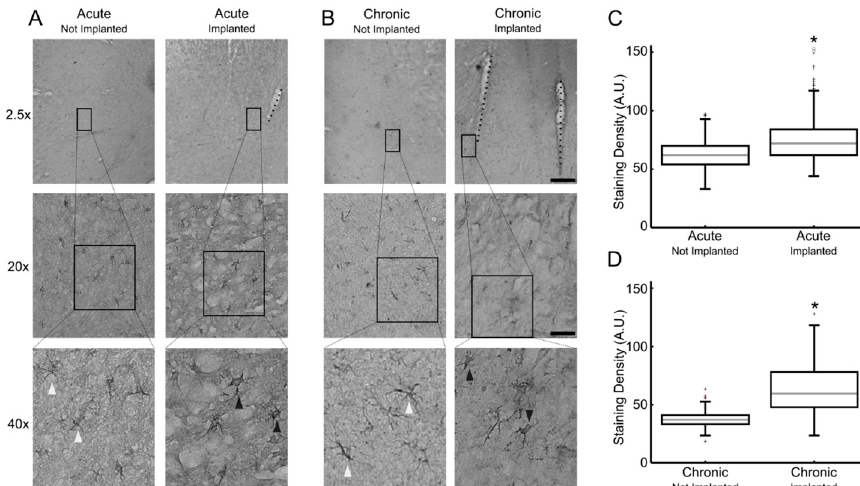
Figure 1. Astrocytes observed in brain tissue from marmosets with acute and chronic microelectrode implants. Representative images from glial fibrillary acidic protein (GFAP) staining in acutely- ( A ) and chronically-implanted ( B ) animals at 2.5 × , 20 × , and 40 × objective magnifications. Representative inactive morphology astrocyte (white arrowhead), active morphology astrocyte (black arrowhead), and microelectrode tracks (black dashes) are highlighted. Scale bars indicate 350, 140, and 75 µ m, for 2.5 × , 20 × , and 40 × objectives, respectively. Box plots of the GFAP-immunostaining densities observed in acute ( C ) and chronic ( D ) sections; asterisks indicate statistically significant difference relative to respective not-implanted region p < 0.05. A.U.: Arbitrary units.